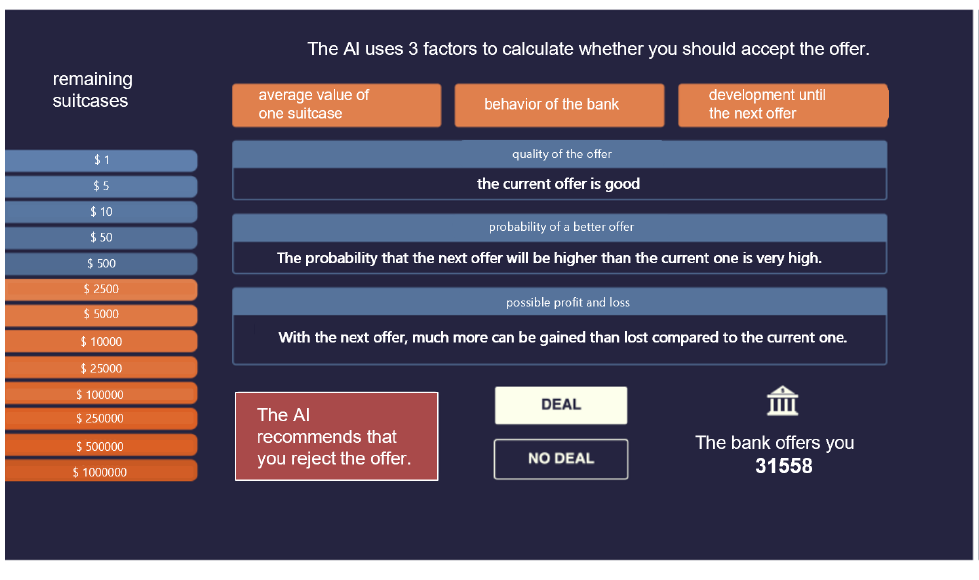
Figure 4. Example of a display in the ’simple’ explanation condition. In the no explanation condition, only the advice was shown. No explanation was given (Figure